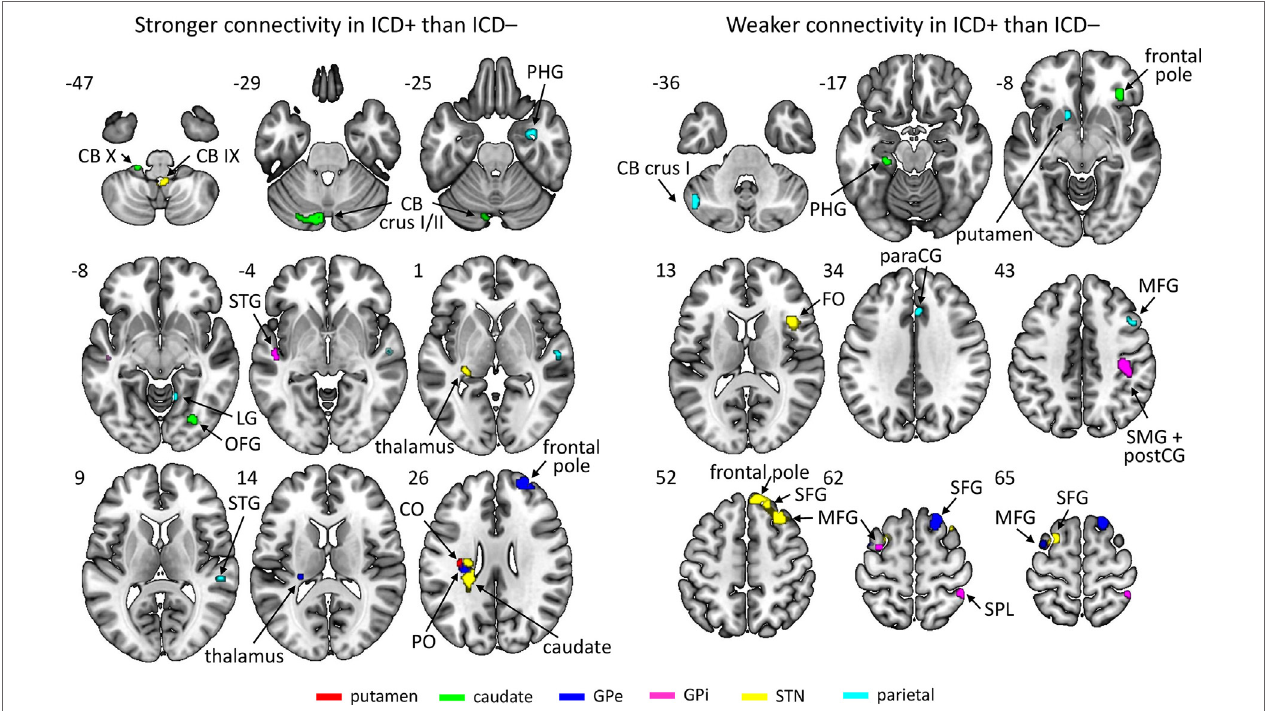
FigUre 2 | Regions showing stronger (left) or weaker (right) connectivity with their respective region of interest in the impulse control disorder (ICD) + group than in the ICD − group. The key for the abbreviations can be found in the notes of Table 2